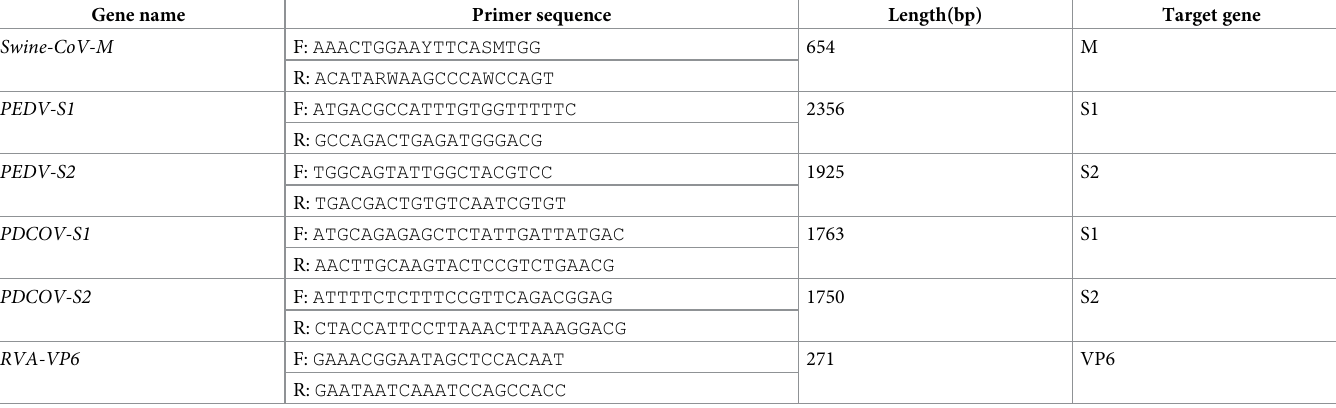
Table 2. List of primers used in this